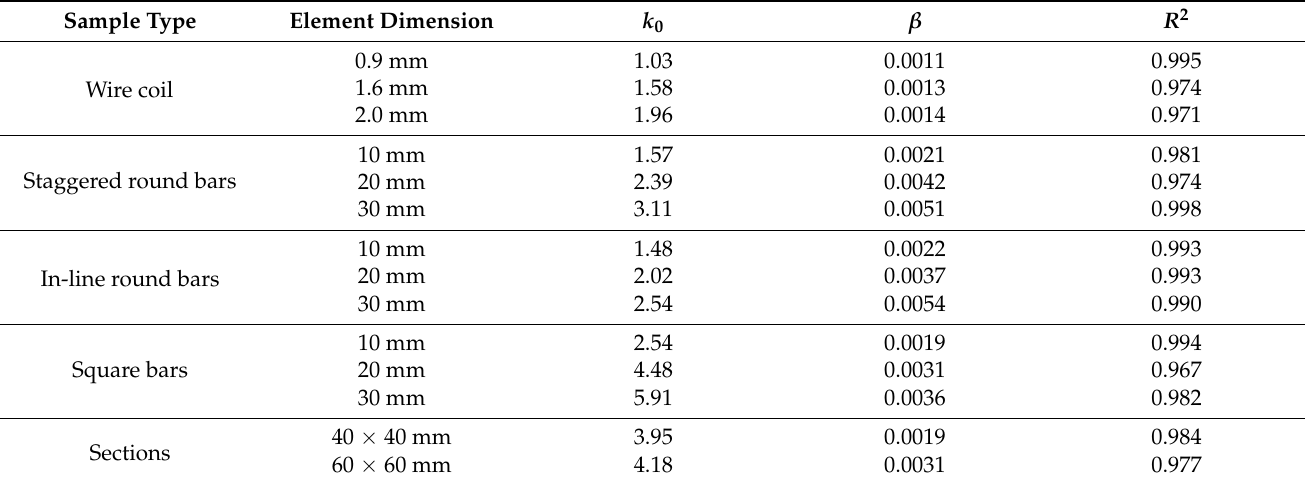
Table 1. The values of k 0 , β and R 2 coefficients for the investigated